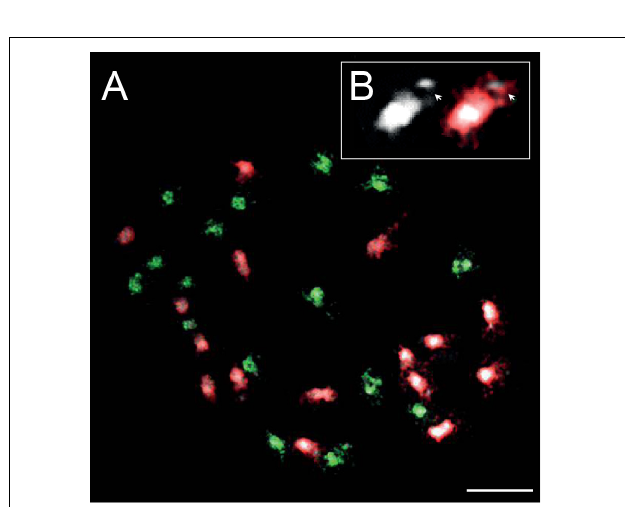
FIGURE 8 | Genomic in situ hybridization (GISH) on mitotic chromosomes in the allotetraploid Cardamine barbaraeoides (2 n = 32). (A) GISH with total genomic DNA of Cardamine acris subsp. acris (red fluorescence) and Cardamine amara subsp. balcanica (green fluorescence) revealed two subgenomes contributed by ancestors of the two diploid species. (B) Close-up view of a heterochromatic knob-bearing chromosome (the terminal knob marked by arrowheads). Chromosomes were counterstained by 4 (cid:48) ,6-diamidino-2-phenylindole (DAPI); scale bar, 10 µ